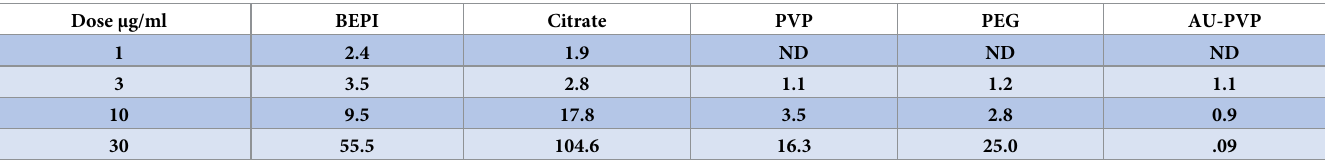
Table 2. Surface Plasmonic Resonance (SPR) vs dose. Dose μ g/ml